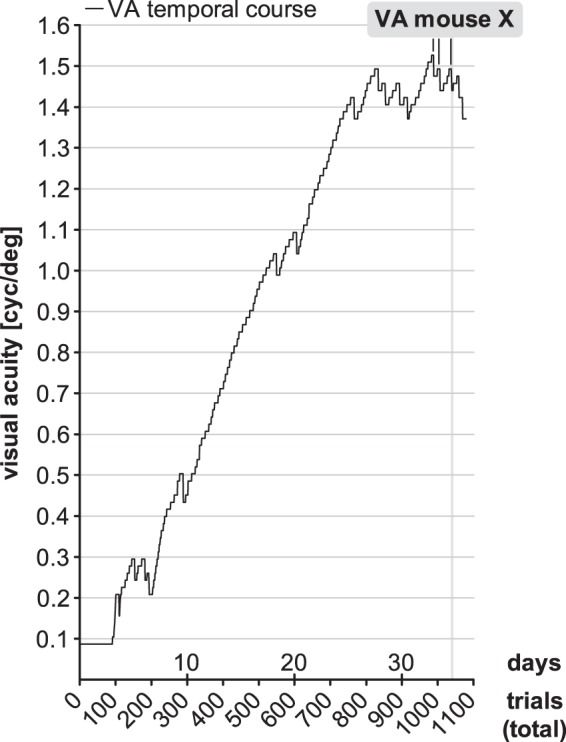
Mouse X reached a VA of 1.49 cyc/deg after 34 d of VWT training (1040 trials). This individual mouse exhibited a consistent behavioral strategy for deciding where to swim: it held onto the midline divider (see also Video 1). Data plotted as in Figure 2A.